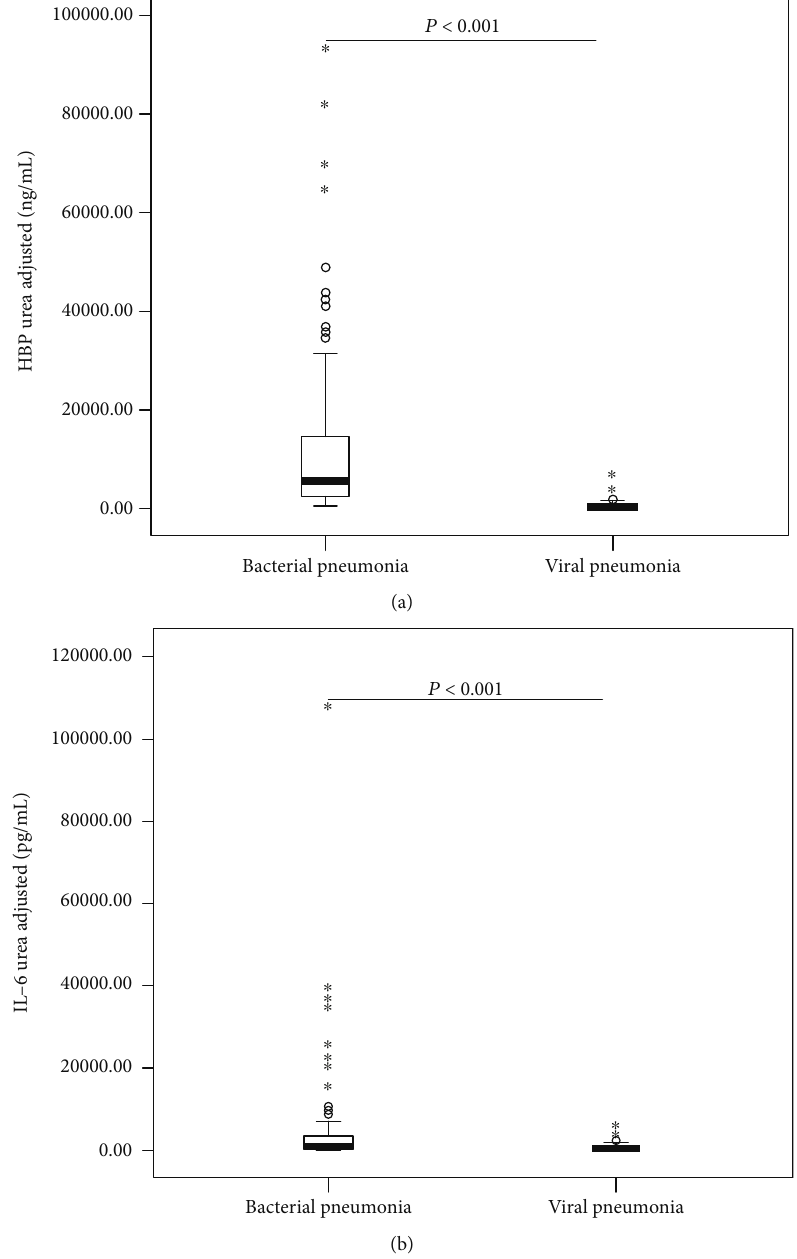
Figure 4: Urea-adjusted values for BALF HBP (a) and IL-6 (b) in children with bacterial or viral pneumonia. HBP: heparin-binding protein; IL-6: interleukin-6; BALF: bronchoalveolar lavage fl uid. Error bars: 95.00% con fi dence